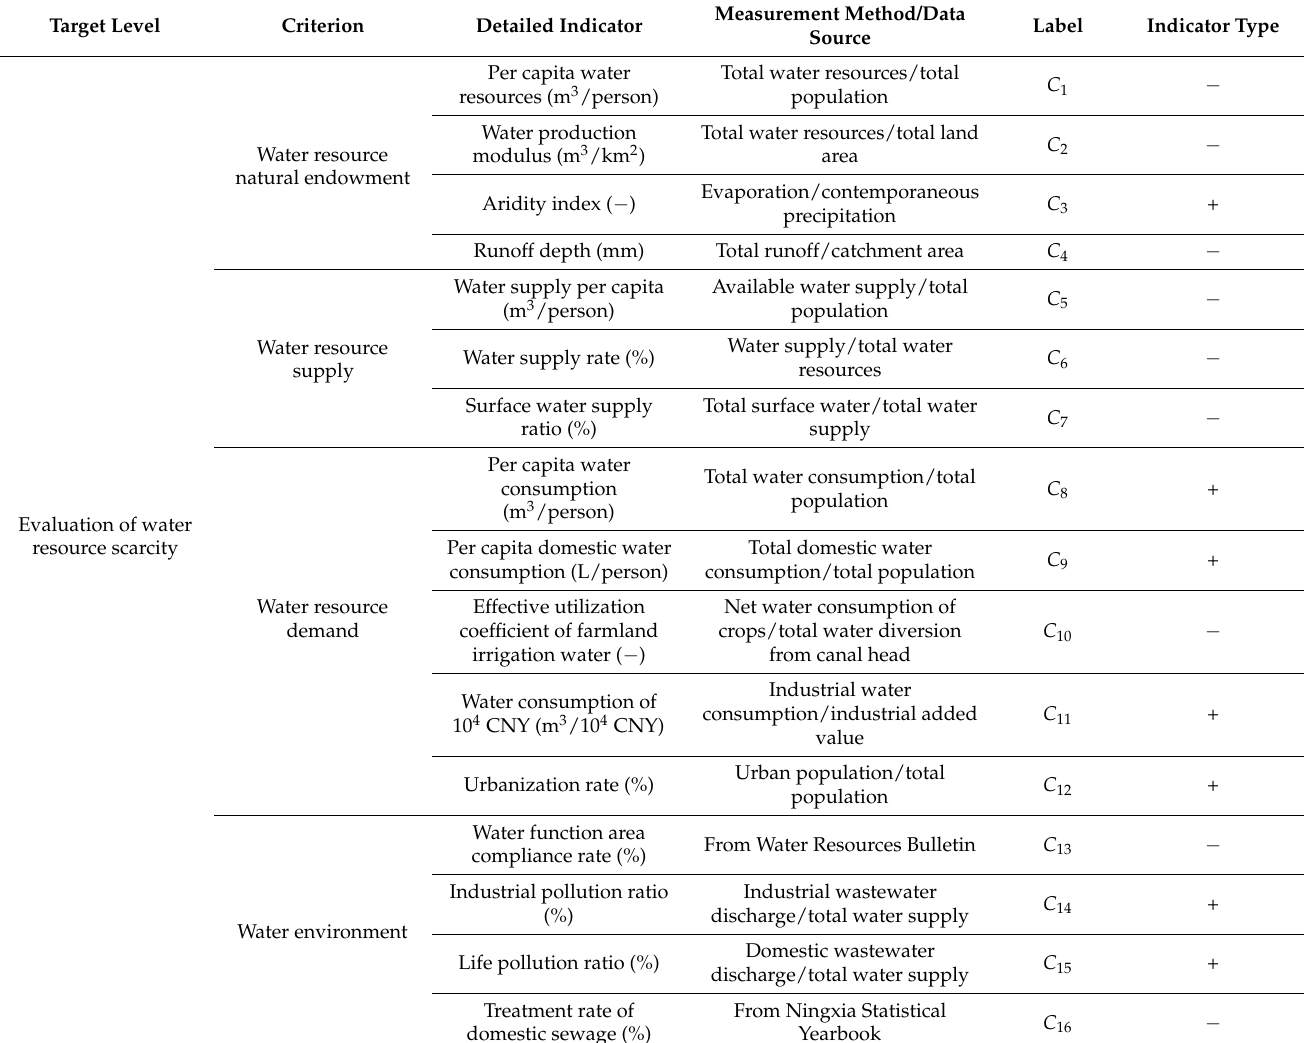
Table 1. Index system of water resource scarcity